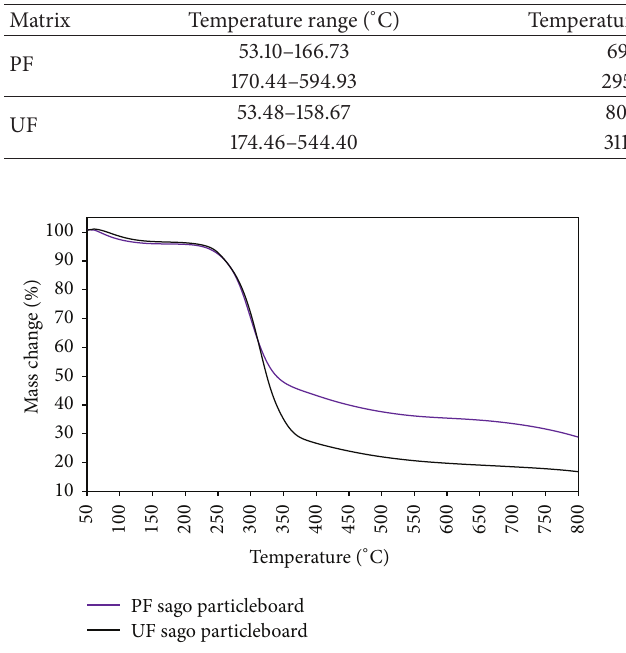
Figure 10: TGA of PF and UF sago particleboard.